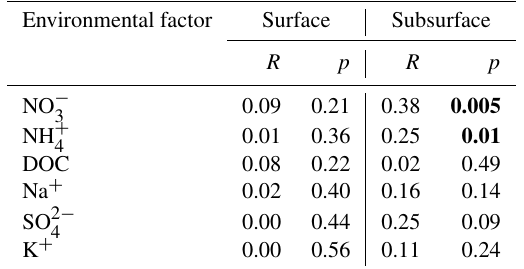
Table 1. Results of Mantel test showing the relationships between bacterial community composition and environmental factors in the surface and subsurface snow. Significant correlations are in